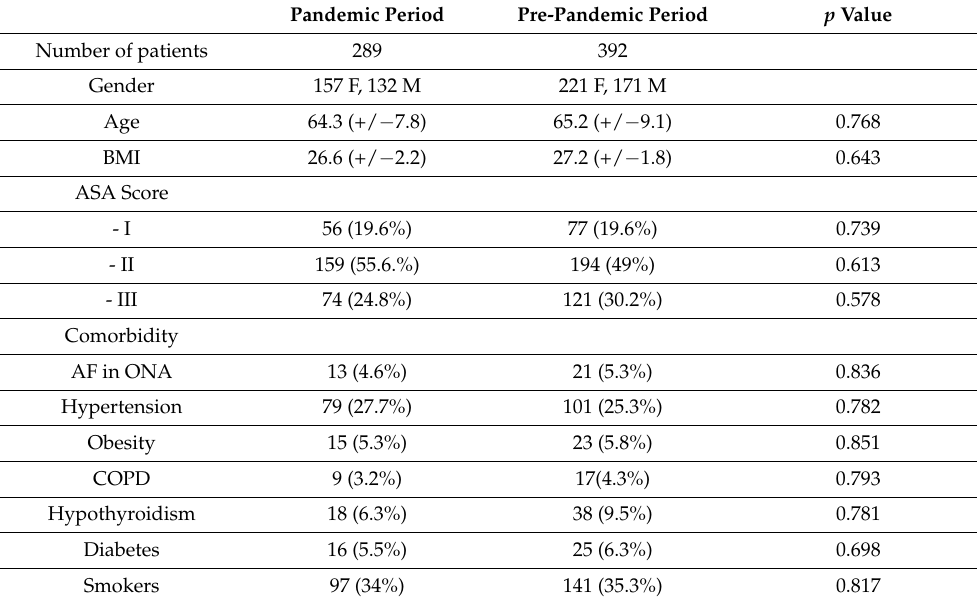
Table 2. Demographics features of patients underwent to instrumented spinal